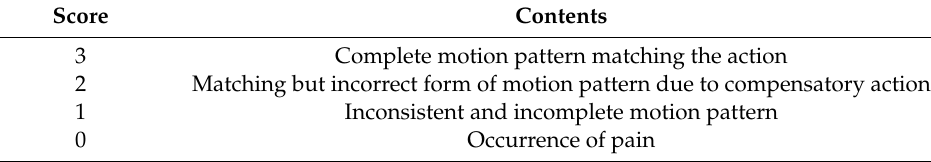
Table 2. Scores of the contents in the Functional movement screen evaluation.